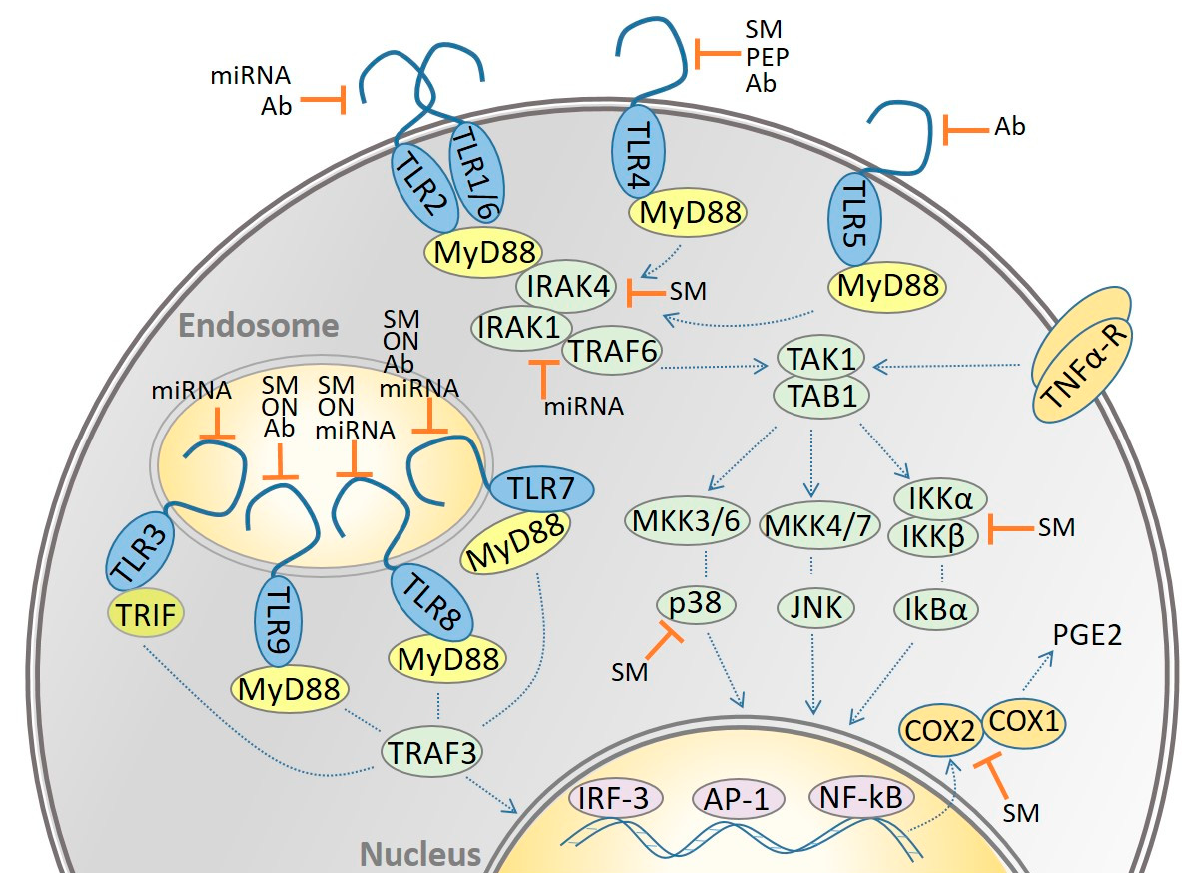
Figure 1. Constituents of the TLR pathways that have been targeted in inflammatory arthritis. Several kinds of pharmacological agents that modulate TLRs and downstream proteins have been shown to have in vitro, in vivo or clinical therapeutic effect in different inflammatory arthritis pathologies. Ab: antibodies; SM: small-molecules; PEP: peptides; ON: oligonucleotides; miRNA: microRNA.